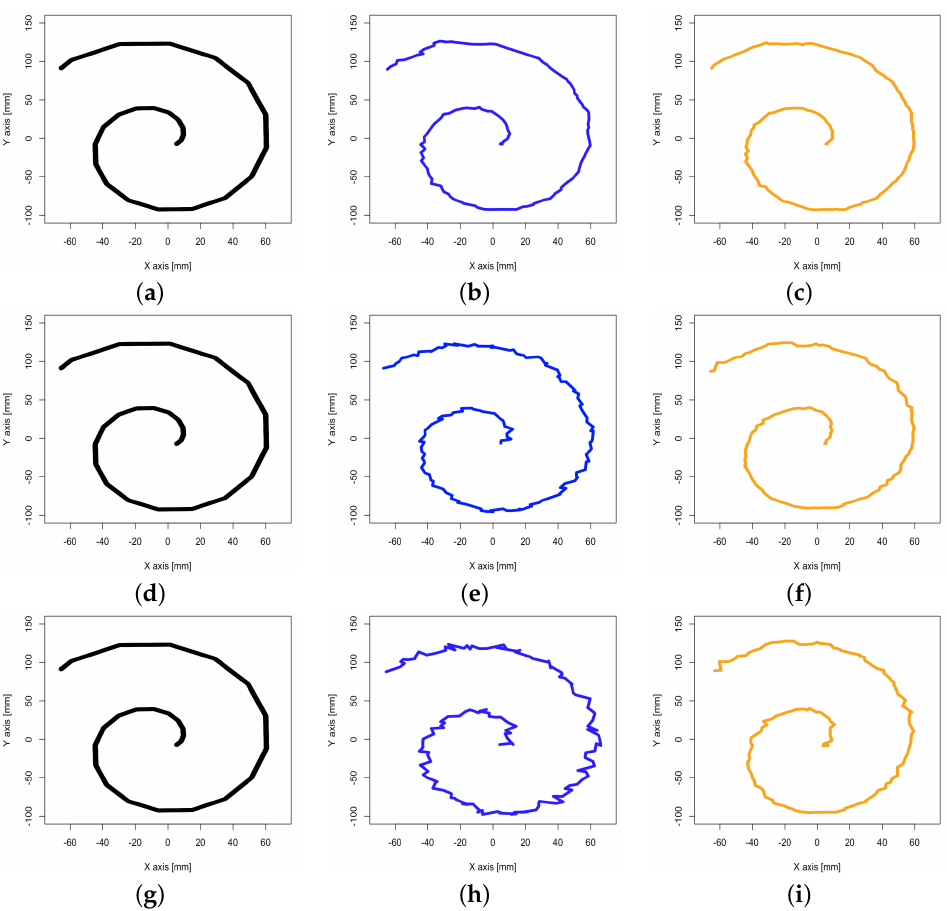
Figure 6. Mean spiral trajectory at velocities 12.5 mm/s (slow), 25 mm/s (medium), and 50 mm/s (fast) for Universal Robots UR10 robot arm (black) with mounted VIVE Tracker (3.0) and setups with two (blue) and four (orange) SteamVR Base Stations 2.0: ( a ) Robot arm, slow. ( b ) Two base stations, slow. ( c ) Four base stations, slow. ( d ) Robot arm, medium. ( e ) Two base stations, medium. ( f ) Four base stations, medium. ( g ) Robot arm, fast. ( h ) Two base stations, fast. ( i ) Four base stations,